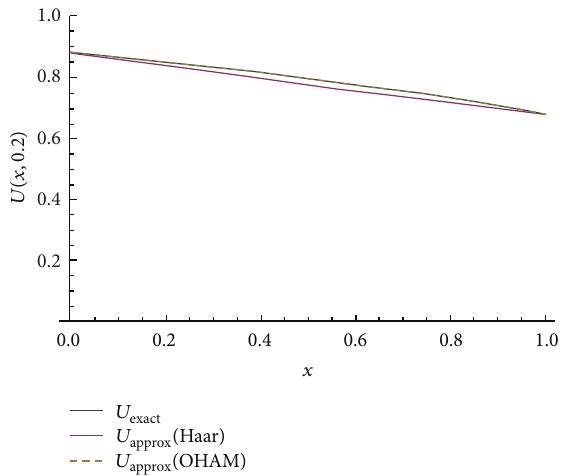
Figure 1: Comparison of Haar wavelet solutions and OHAM solutions with the exact solution of Burgers-Fisher equation when 𝑡 = 0.2 .